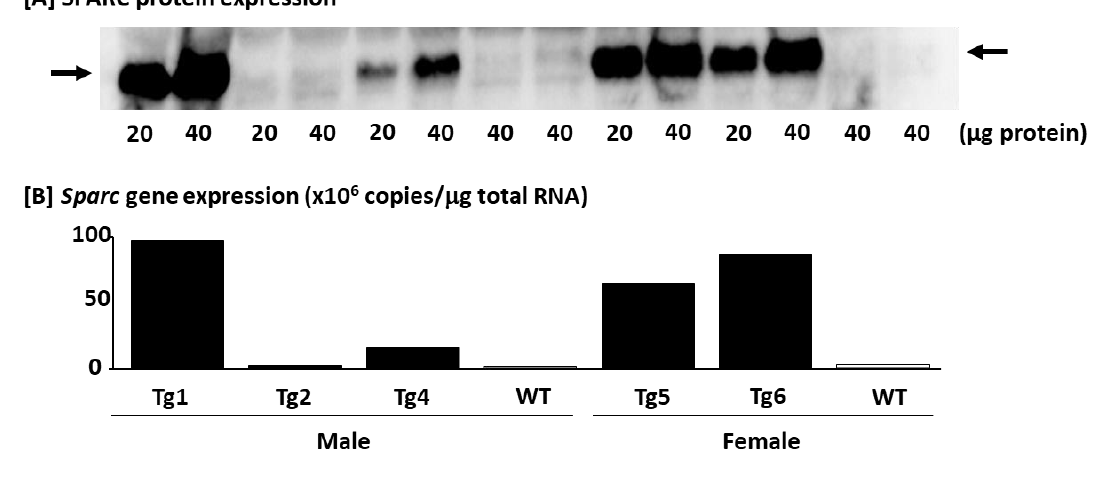
Figure 7. SPARC expression in the tibialis anterior muscle of Sparc transgenic (Tg) and wild-type (WT) F0 mice. ( A ) SPARC protein expression analyzed by Western blot. ( B ) Sparc gene expression analyzed by quantitative real-time PCR. Abbreviations: SPARC/ Sparc , secreted protein acidic and rich in cysteine; Tg, transgenic ( Sparc overexpression); Tg1, Sparc Tg line 1; Tg2, Sparc Tg line 2; Tg4, Sparc Tg line 4; Tg5, Sparc Tg line 5; Tg6, Sparc Tg line 6.